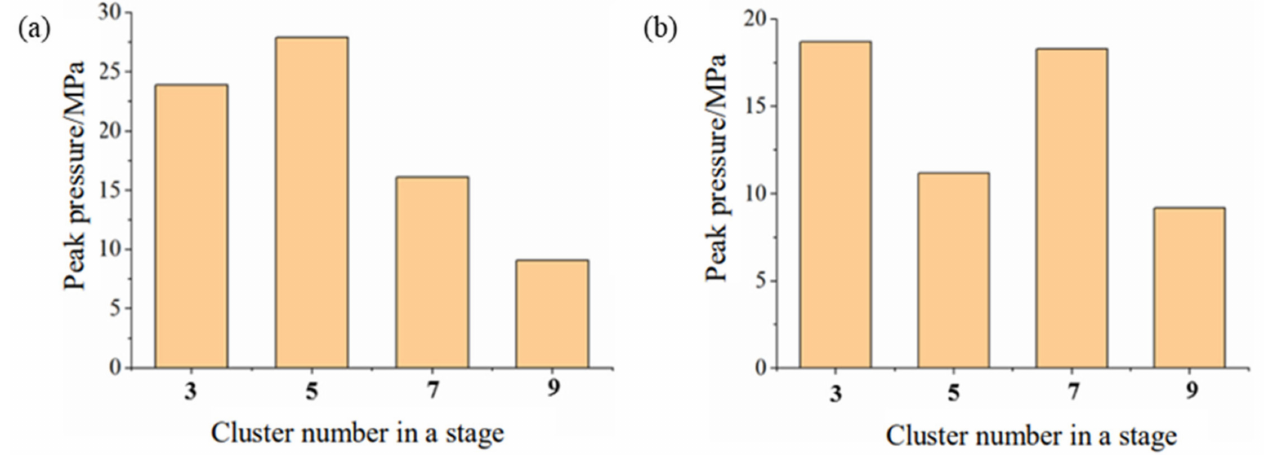
Figure 11. Relationship between the number of clusters in a single stage and peak pressure of the intrafracture and intrastage temporary plugging fracturing: ( a ) intrafracture peak pressure; ( b ) intrastage peak